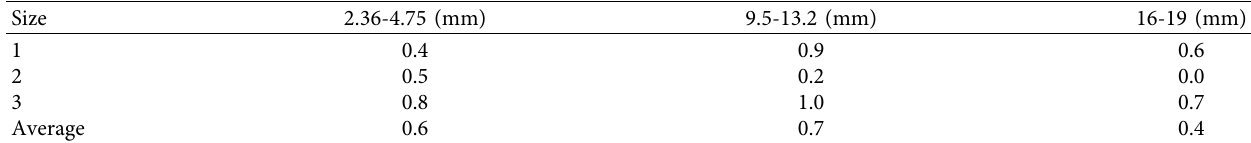
Table 7: Difference between the existing method and the proposed method